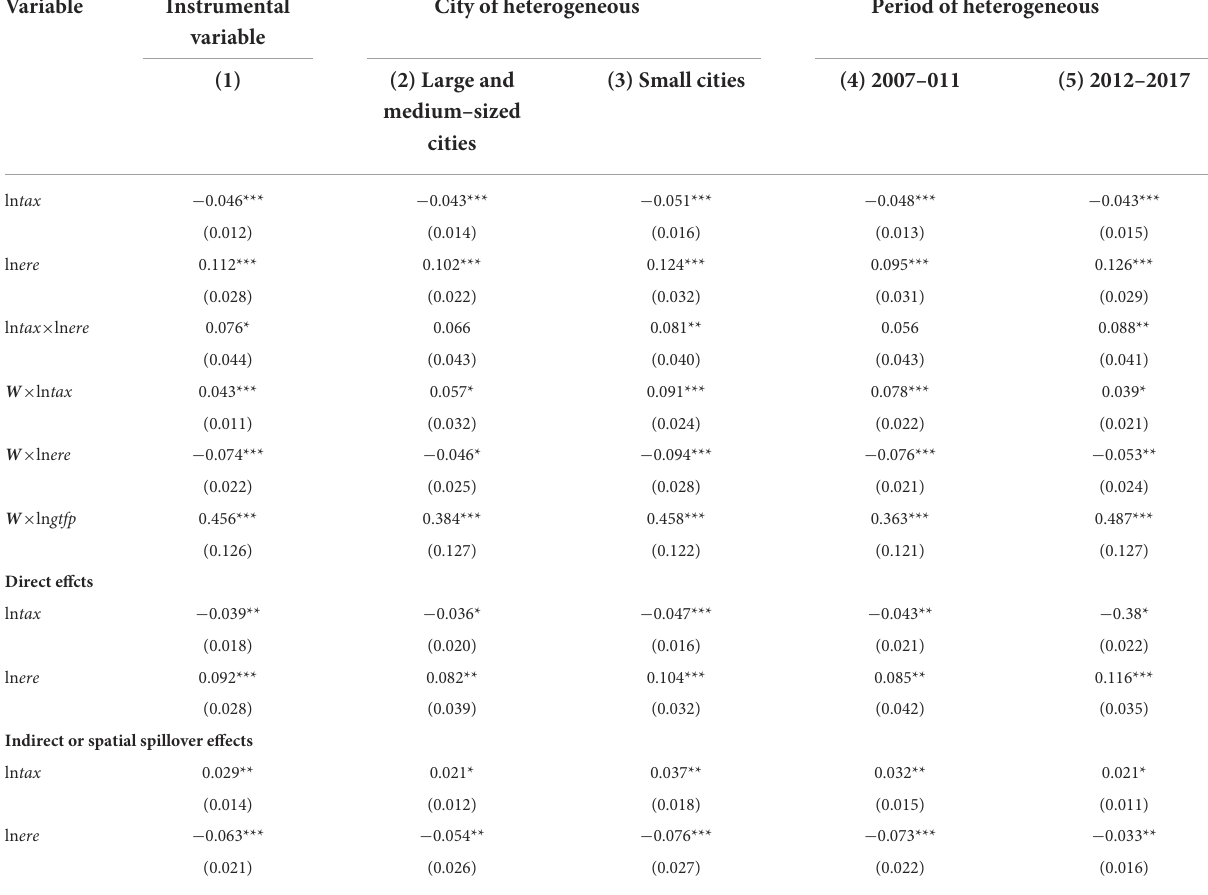
TABLE 6 Results of instrumental variable and heterogeneous